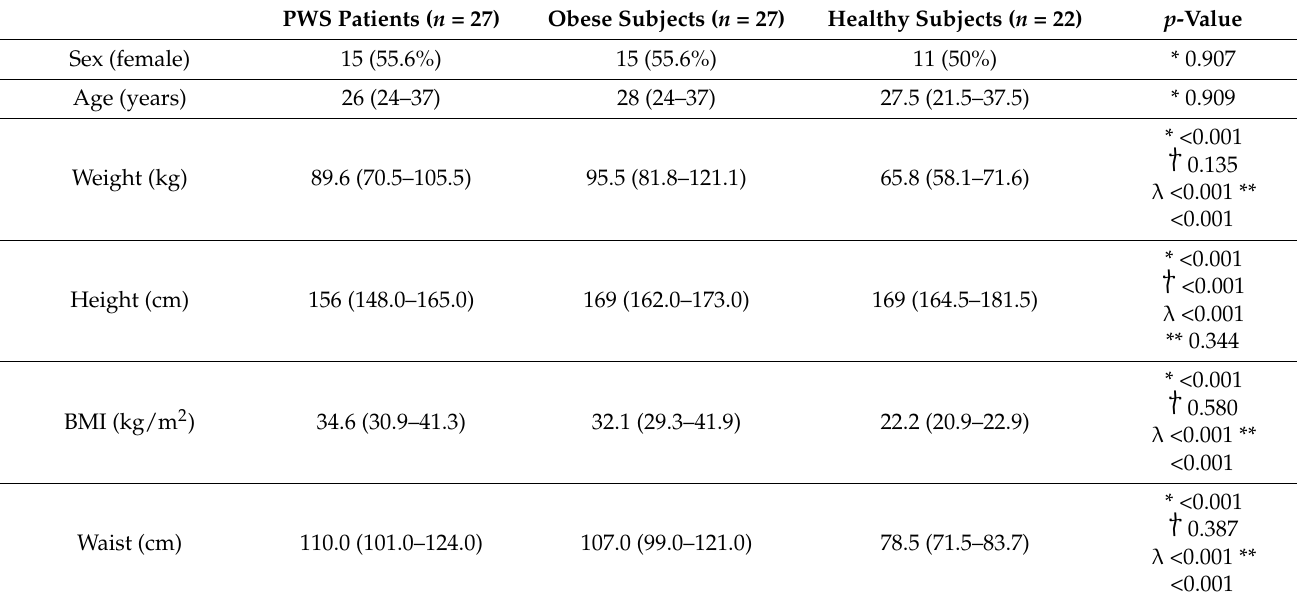
Table 1. Baseline characteristics of participants.